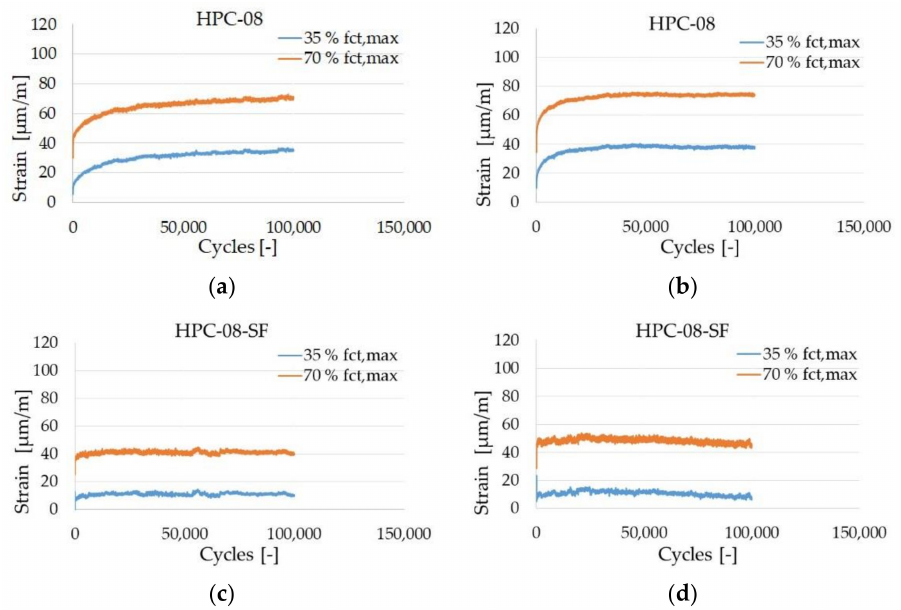
Figure 13. Examples of strain-cycle (S-N) diagrams of: ( a , b ) HPC-08; ( c , d ) HPC-08-SF up to 100,000